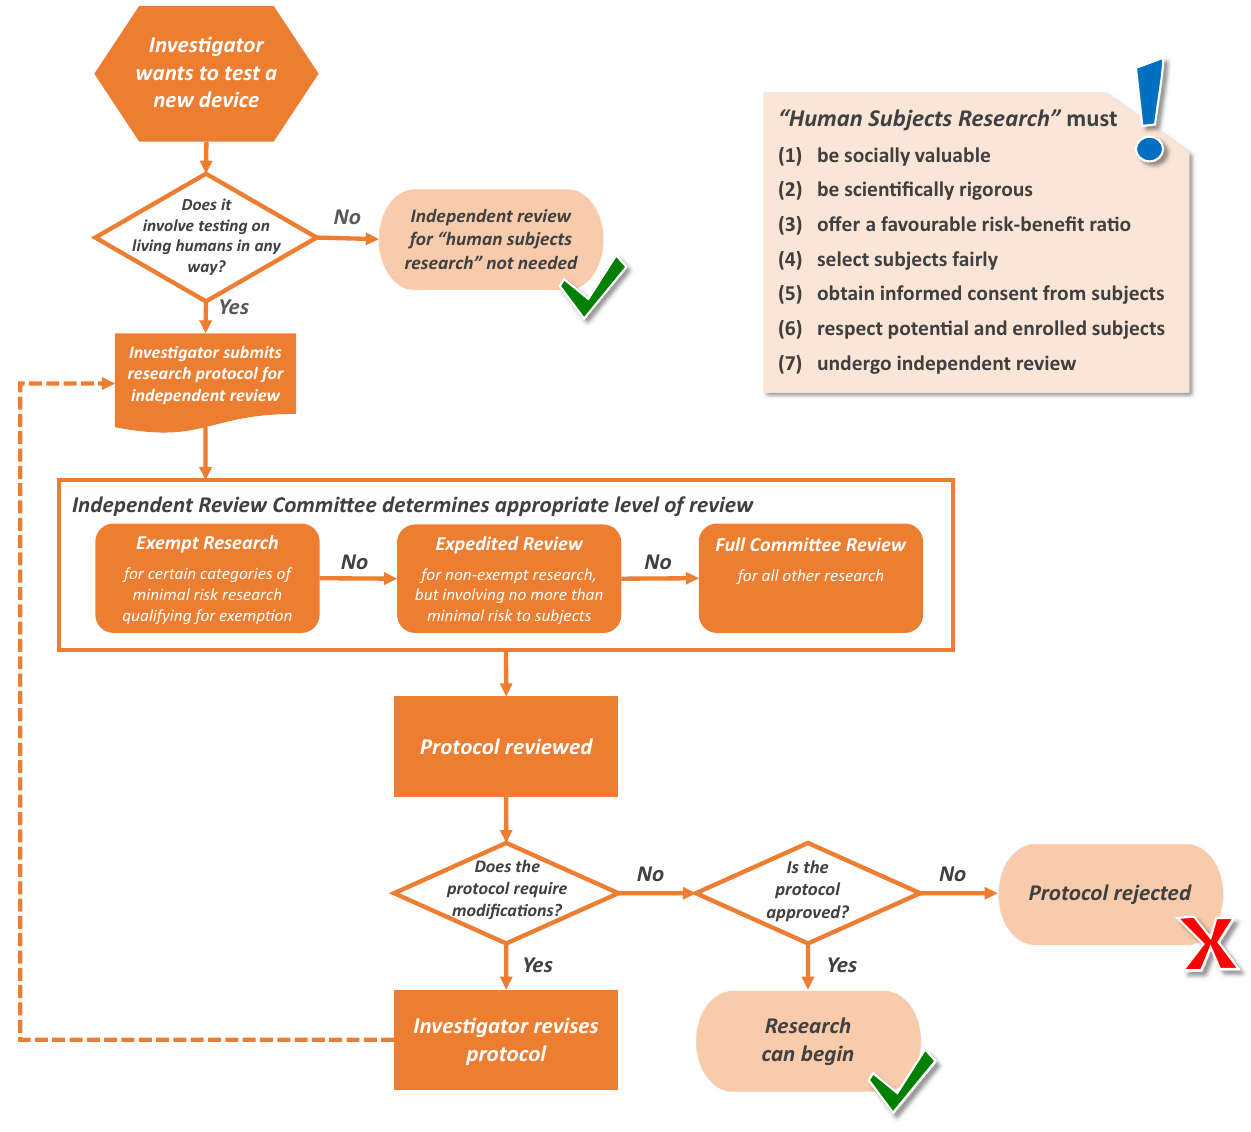
Fig. 1 | Process for independent review of a device being tested in human subjects in the United States. A researcher developing a new device